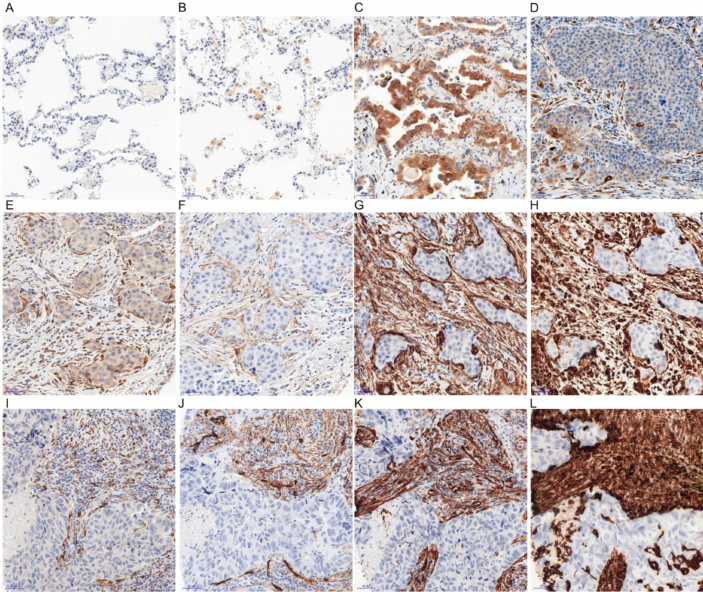
Figure 1. Positive immunohistochemical reactions (IHC - brown colour) indicating irisin expression performed on healthy lung tissue ( A , B ) as well as in di ff erent subtypes of NSCLC in AC cancer cells ( C ) and stromal cells ( E ), in SCC cancer cells ( D ) and in stromal cells ( I ). Lack of irisin expression—healthy lung tissue ( A ), irisin expression in macrophages ( B ). Comparison of irisin expression in cancer stroma with PDPN (in AC— F , in SCC— J ), α SMA (in AC— G , in SCC— K ) and Vimentin (in AC— H , in SCC— L ) magnification, 200 ×